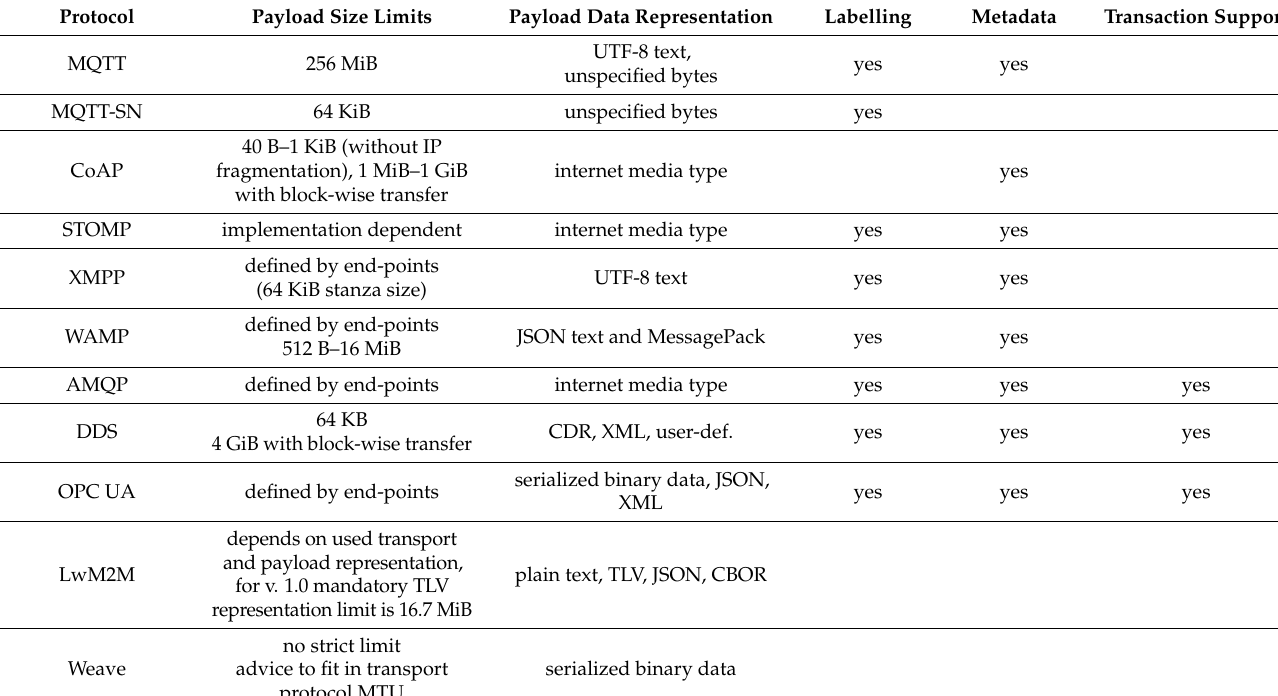
Table 2. Messaging